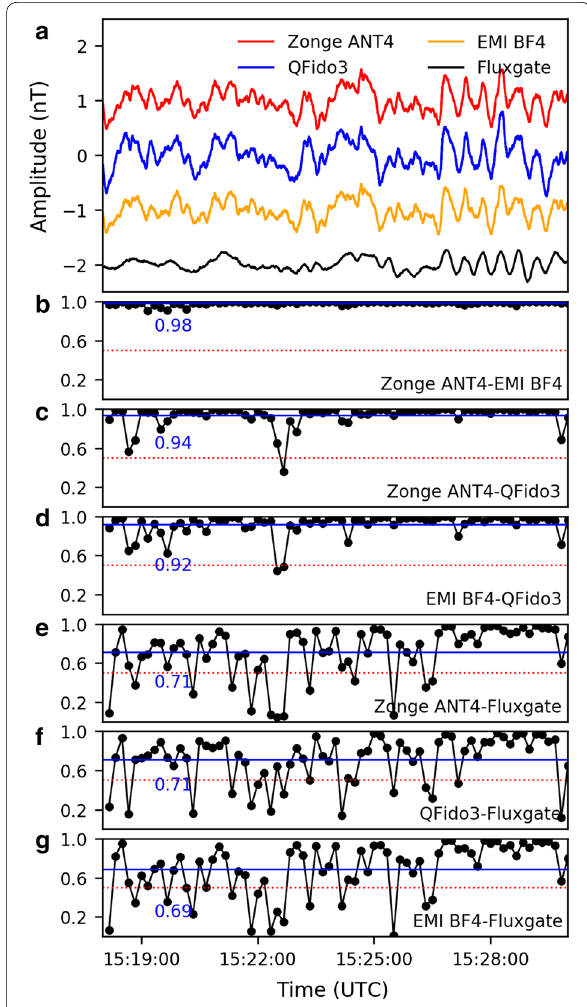
Fig. 12 a Data for the period 15:18–15:30 UTC, April 17, 2017. b – g Cross-correlation coefficients calculated at 20-s intervals over the same time period between all pairs of north-oriented sensors. b Zonge ANT4 versus EMI BF4, c Zonge ANT4 versus QFido3, d EMI BF4 versus QFido3, e Zonge ANT4 versus Fresno Fluxgate, f QFido3 versus Fresno Fluxgate, g EMI BF4 versus Fresno Fluxgate. In each panel, the horizontal blue line shows and is labeled with the mean of the cross- correlation coefficients for the 12-min period, and the red dashed line shows an empirically estimated threshold of 0.5. Cross-correlations of USGS-Stanford and QuakeFinder records b – d are carried out with 200-s high-pass filtered data streams as used elsewhere in this paper; cross-correlations with the Fresno Fluxgate magnetometer that only records at 1 Hz sample rate e – g use a data stream bandpass-filtered with a 1–200-s Butterworth